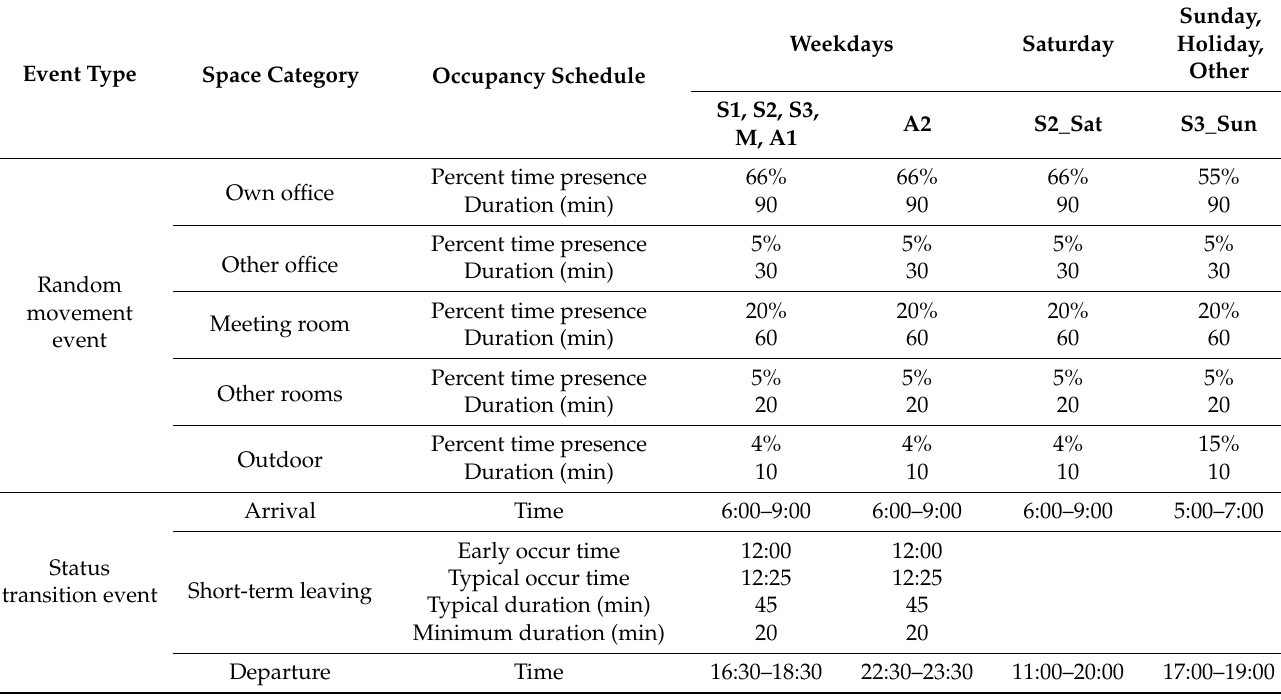
Table 4. The definition of the meeting